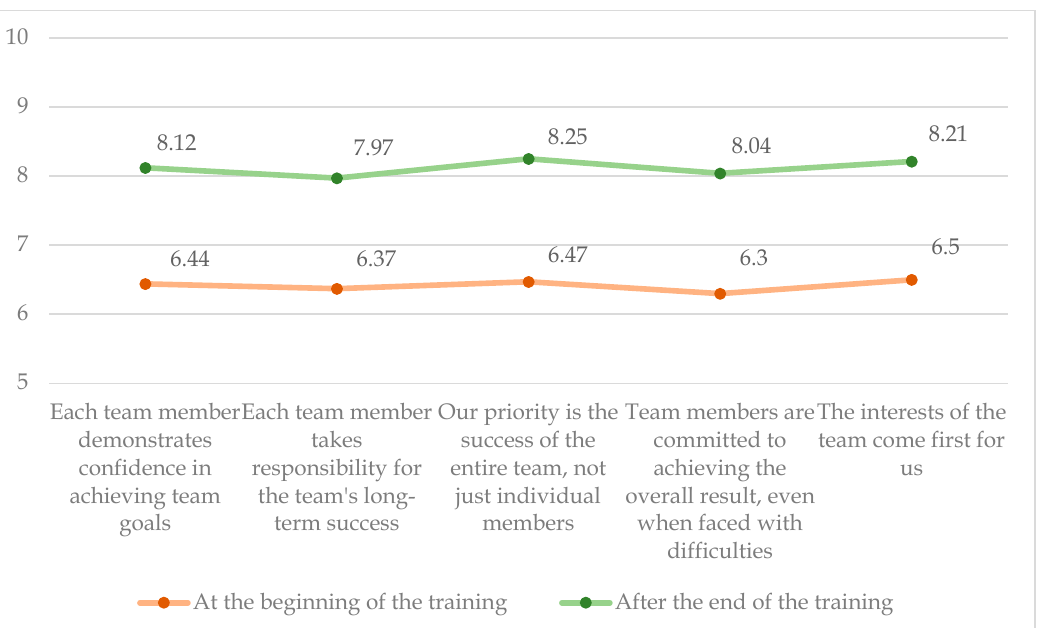
Figure 4. Results of answers to the block of questions “Coordination of team actions” (in comparison of answers to questions at the beginning and after the end of the training).